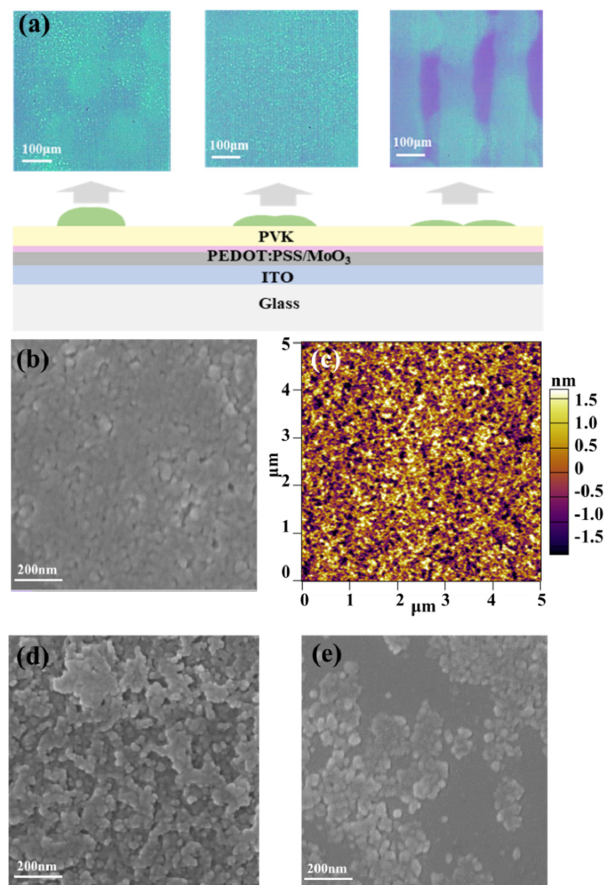
Figure 3. ( a ) Different film morphologies with different print spacing (from left to right, corresponding to 20, 60, and 100 μ m spacing); ( b ) SEM image of the uniform, continuous perovskite film fabricated via inkjet printing with a spacing of 60 μ m; ( c ) a 5 μ m × 5 μ m AFM image (RMS roughness: 0.7 nm) and SEM image (scale bar: 200 nm) of printed perovskite nanocrystal film with a printed spacing of ( d ) 20 μ m and ( e ) 100 μ m.